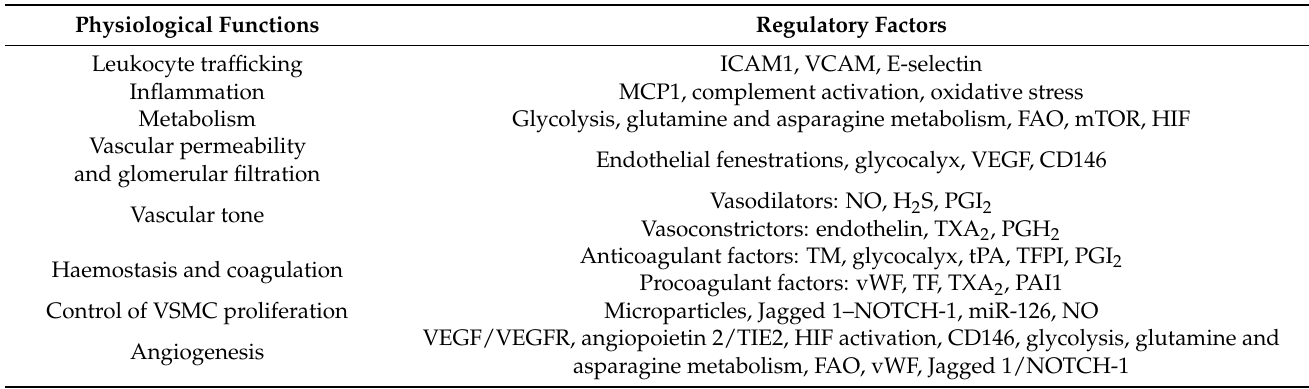
Table 1. Endothelial cell